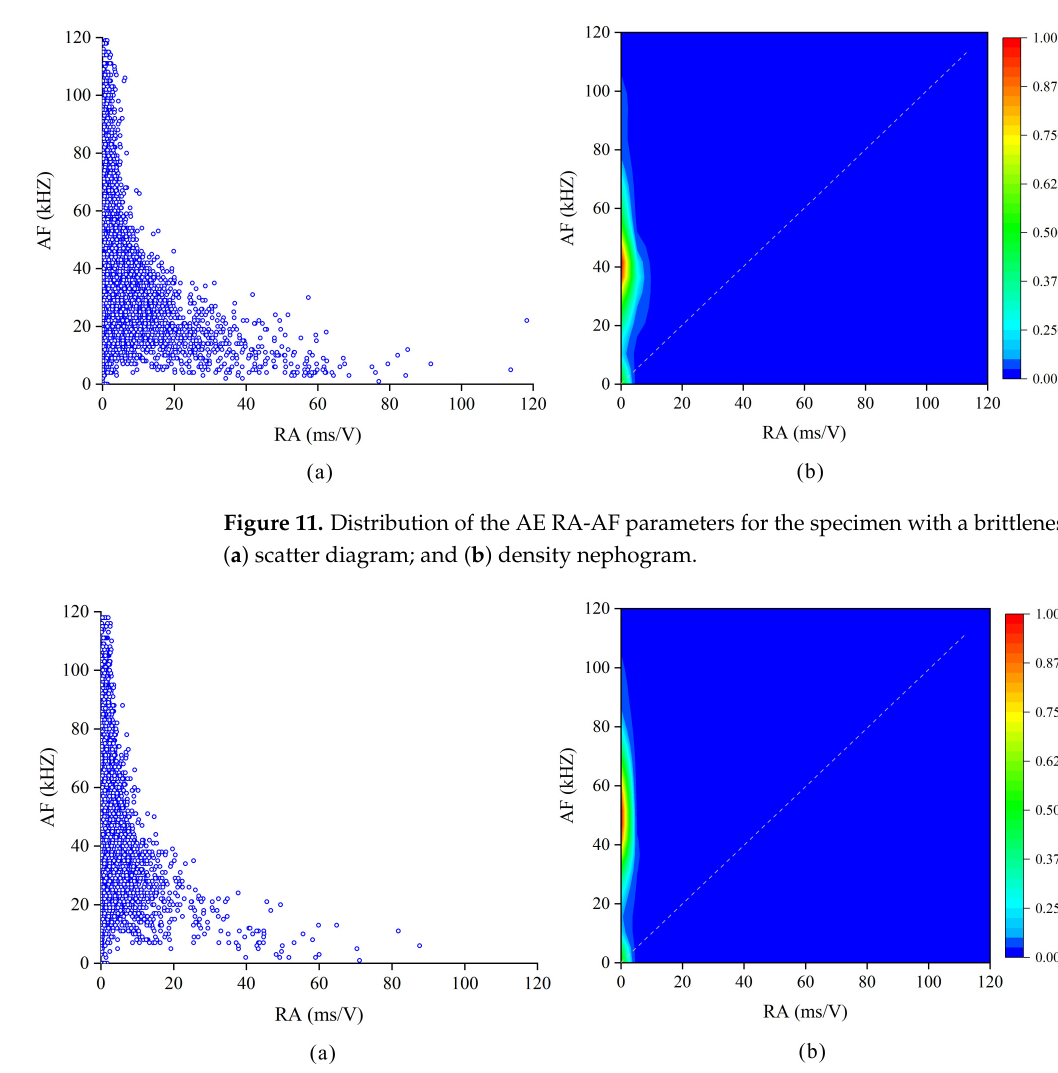
Figure 12. Distribution of the AE RA ‐ AF parameters for the specimen with a brittleness index of 3.36: ( a ) scatter diagram; and ( b ) density nephogram.